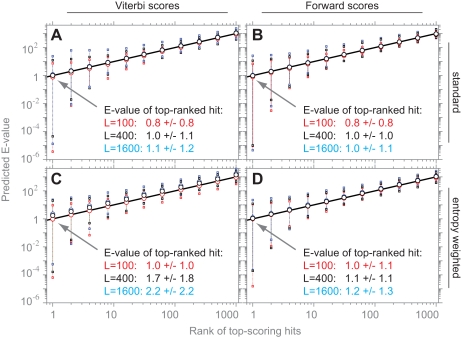
Accuracy of E-value determination.Plots of predicted E-value versus actual rank, for multihit local Viterbi scores (A,C) and multihit local Forward scores (B,D), using models with either the standard profile HMM multinomial parameterization used in the rest of the paper (A,B) or “entropy-weighted” models of reduced information content (C,D). Each plotted point (open circles) is the mean of 9,318 profile HMM searches of n = 105 target sequences of three different target lengths: L = 100 (red), L = 400 (black), and L = 1,600 (cyan). The extreme outliers for each point are shown by squares and dotted vertical lines. (Interquartile ranges are smaller than the circles plotted for the means.) The expected result, of E-value equal to observed rank, is shown as a black line. Displayed text shows means and standard deviations for predicted E-values of the top-ranked score in each search, which should be (and is) about 1.0.